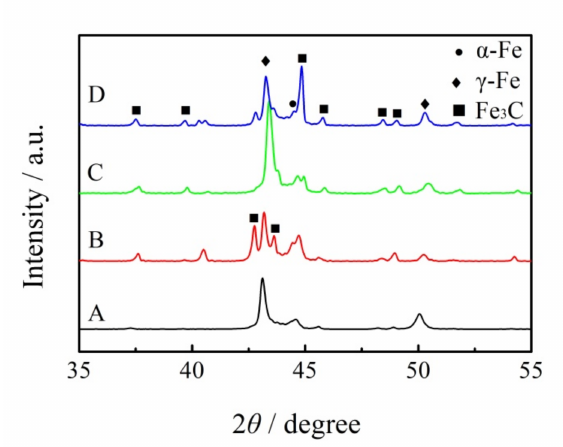
Figure 3. XRD patterns of as-cast ICCI. A, B, C and D is the spectral line of (NbTi)C particles added with 0, 0.15, 0.30 and 0.80 wt %,